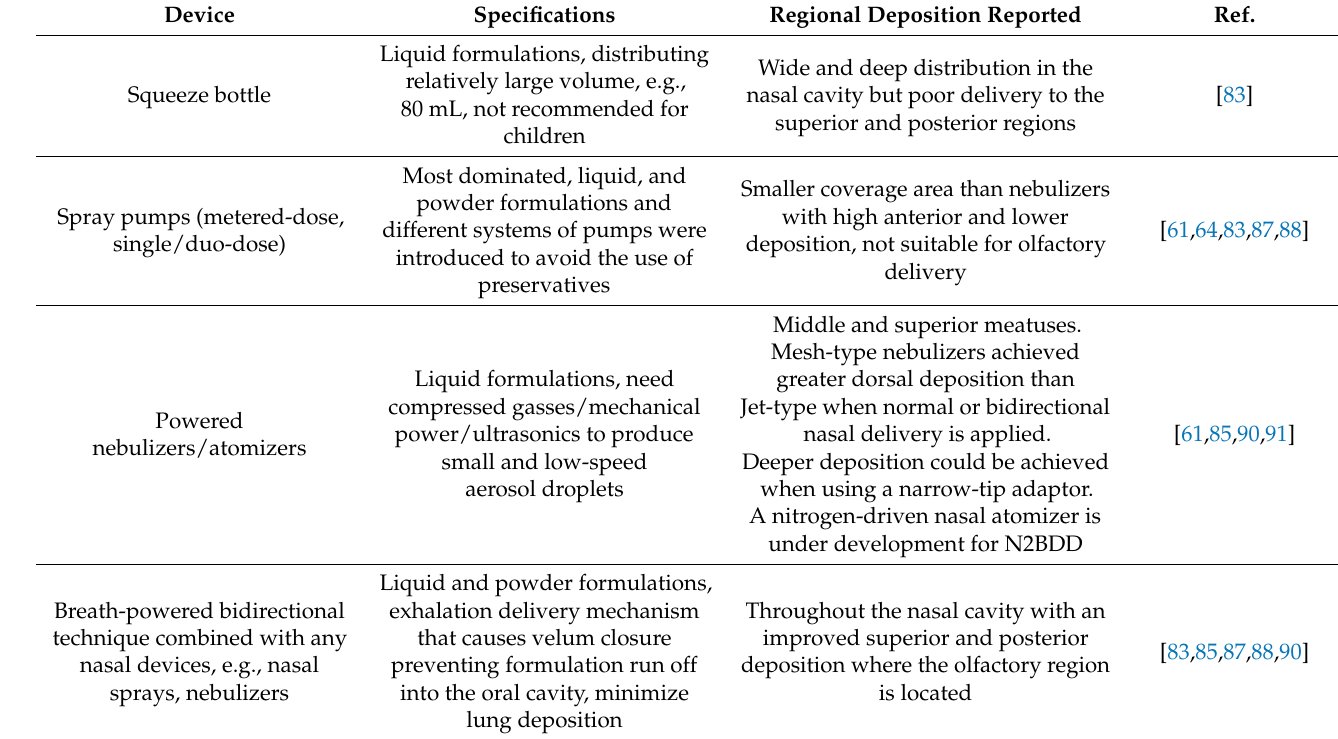
Table 3. Nasal drug delivery